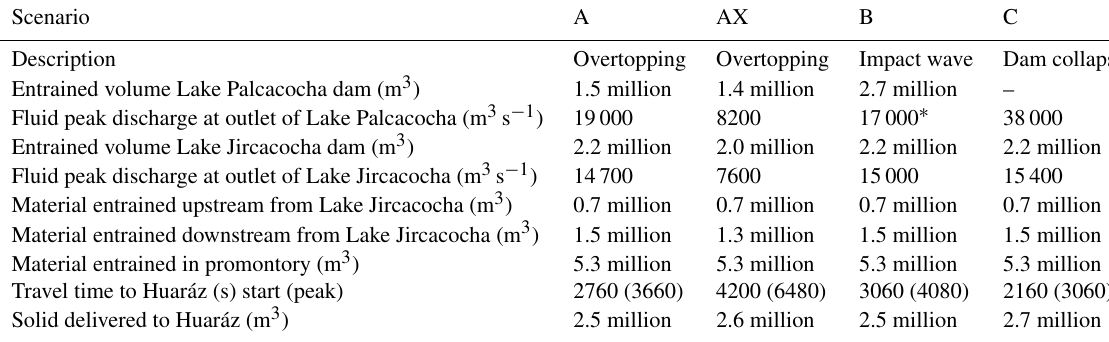
Figure 9. Travel times and frontal velocities for scenarios (a) A and (b) AX. Void fields in the profile graph refer to areas without clearly defined flow front. Table 5. Summary of the key results obtained with the computational experiments A–C. Refer to Tables 1 and 2 for the volumes involved, and to Table 4 for empirically expected peak discharges. Note that all entrained volumes are composed of 80% of solid and 20% of fluid material in terms of